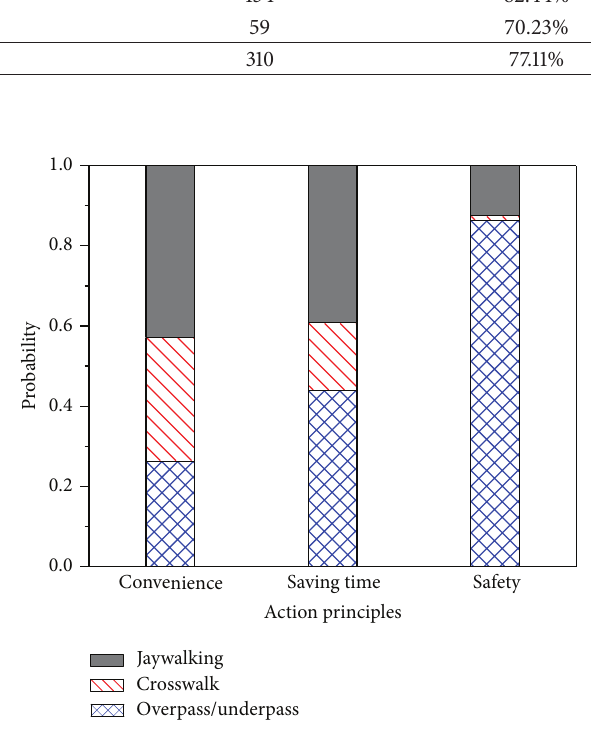
Figure 2: Probability of each alternative with various action princi-